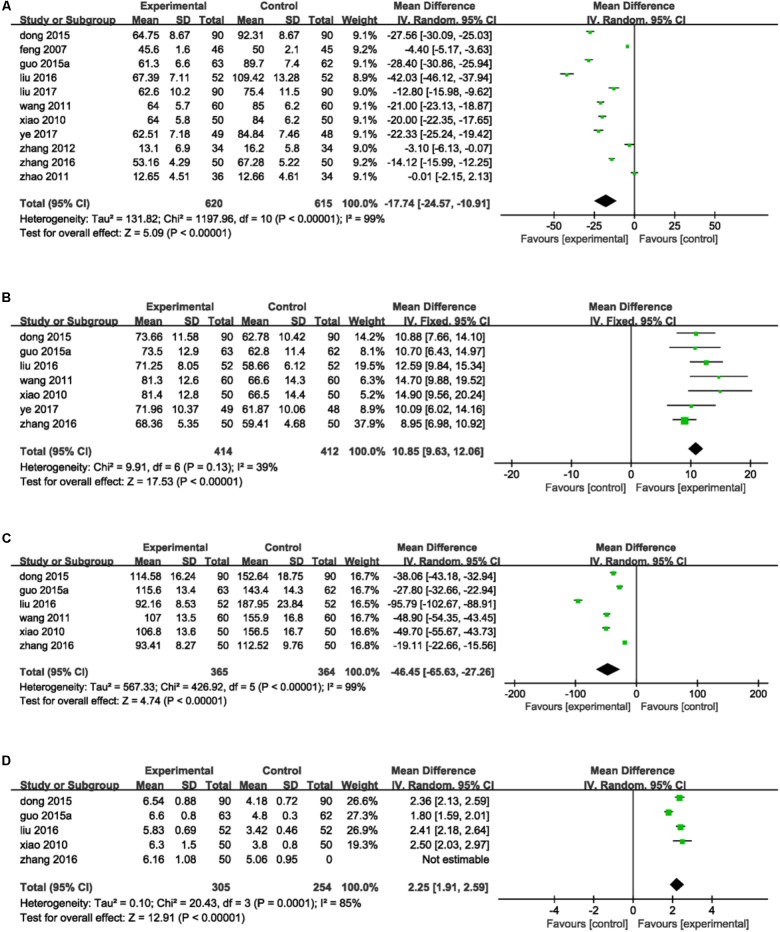
Forest plot of indices of vascular endothelial function in patients treated with DHI + PCI and PCI alone. (A) The plot of ET-1, (B) the plot of NO, (C) the plot of vWF, and (D) the plot of FMD. I2 and P are the criterion for the heterogeneity test. ♦ Pooled odds ratio, ——mean difference and 95%CI.